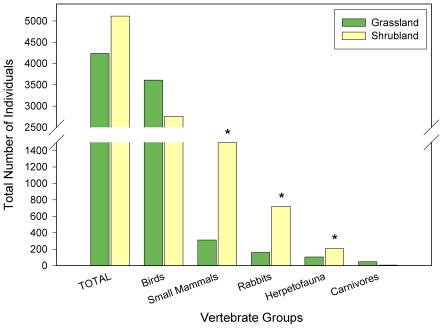
Relative abundance of vertebrate species in grassland and shrubland habitats.Relative abundance of herpetofauna, bird, and small mammal species on the prairie dog colony grasslands and the shrublands over all sample periods (1994, 1995, 1996, 2000, 2001, 2002; N = 8 for each sample period). Asterisks (*) indicate significant differences in abundance between the habitats at P<0.05.